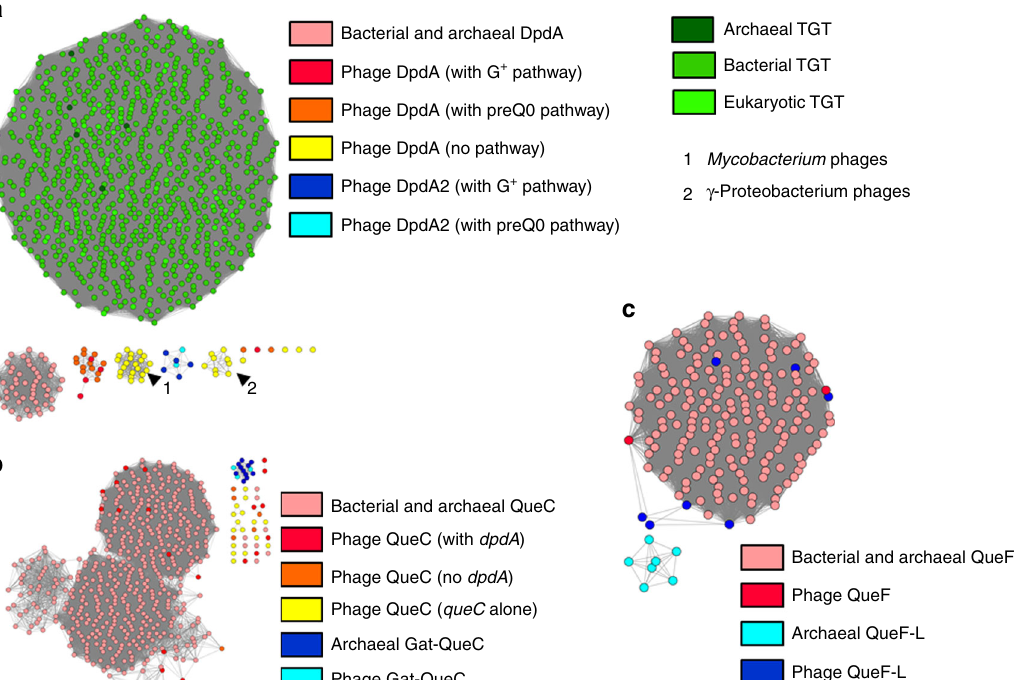
Fig. 4 Protein similarity networks. Source data are provided as a Source Data fi le. a DpdA/Tgt protein network, each node is a group of proteins identical at 90%, and each edge presents an alignment score >15. The TGTs of archaea, bacteria, and eukaryotes are shown in dark green, green, and light green, respectively. Bacterial DpdA are shown in light red. The phage DpdA are separated depending on the gene content of phages: in red, DpdA in genomes encoding the G + pathway; in orange, the preQ 0 pathway; in yellow, the genomes with only dpdA ; in dark blue, DpdA2 with G + pathway; and in light blue, DpdA2 with a preQ 0 pathway. The arrow shows clusters of nodes speci fi c to a clade of a bacterial host (1 is Mycobacterium and 2 is γ - Proteobacteria ). b QueC protein network, with a threshold alignment score of 44. In light red, the QueC from bacteria; in dark red, the QueC from phages that encode a DpdA; in orange, the QueC from phages that are not encoding a DpdA; and in yellow, the QueC from phage encoding only a QueC. Gat-QueC from archaea is in dark blue and from phages is in light blue. c QueF protein network with an alignment score threshold of 10. In light red, the bacterial QueF; and in dark red, the protein identi fi ed as phage QueF. In light blue, the archaeal QueF-L; and in dark blue, the phage protein identi fi ed as